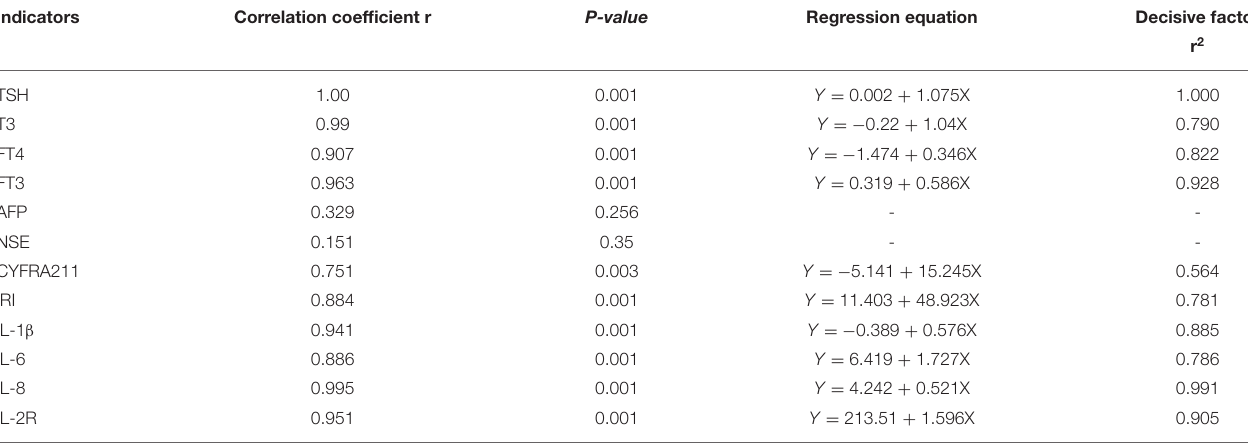
TABLE 3 | Correction equation for the results of some test items after inactivation.